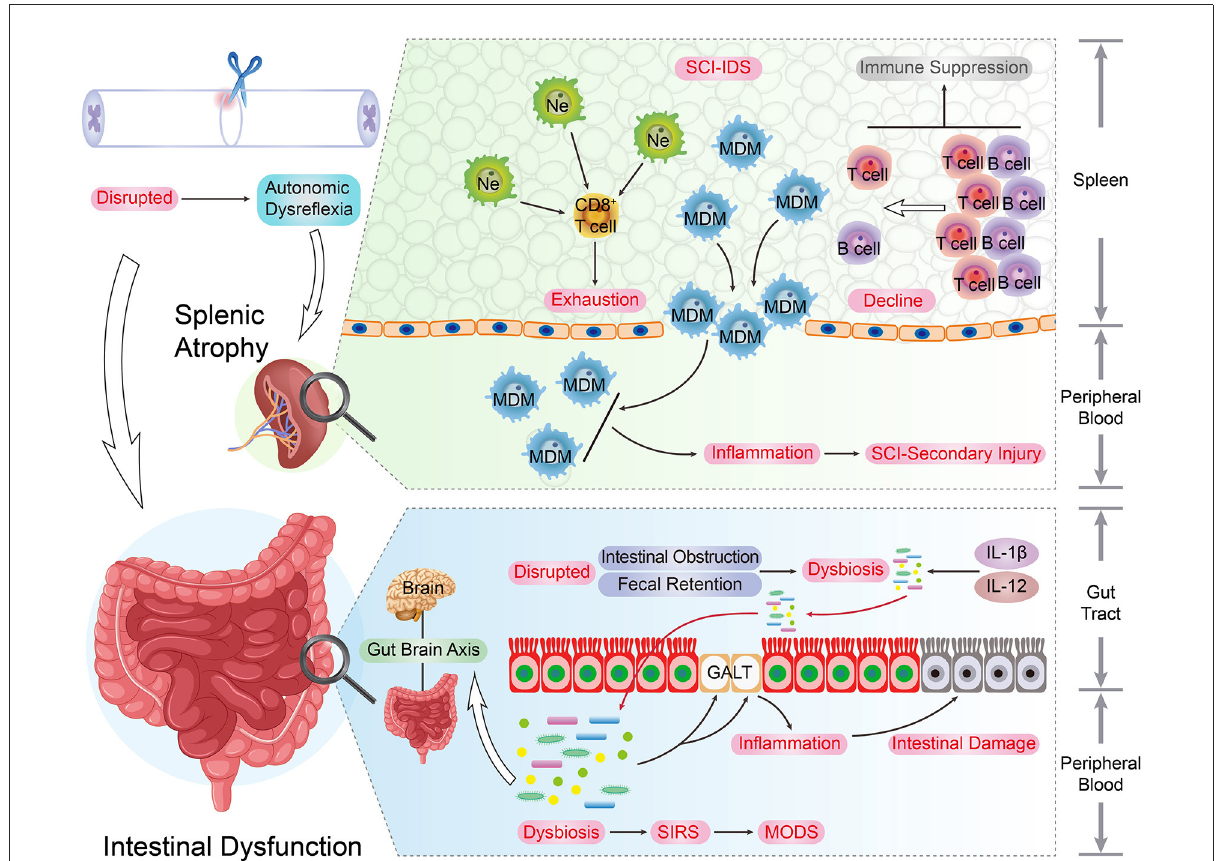
FIGURE3 The immune organs and SCI recovery. As the development and storage places of immune cells, immune organs are indispensable for the immune system’s smooth and effective operation. The upper spinal cord segment injury led to the autonomic dysreflexia status. Under this circumstance, the excessive norepinephrine and activated β -AR signaling result in adverse spleen dysfunction, such as splenic atrophy and immune cells secretion inhibition, and the quantity of peripheral and splenic CD4 + and CD8 + T cells underwent a decrease post-SCI. In addition, due to the surplus norepinephrine stimulation post-SCI, the immune activity and cytokine secretion capacity of splenic CD8 + T cells were impaired. These changes can be regarded as the typical hallmarks of SCI-IDS. Post SCI, the stress-induced intrinsic enteric nervous system interruption results in intestinal complications such as intestinal obstruction, fecal retention, and infections. As consequence, this situation raises the incidence of dysbiosis and induces immunity dysfunction, systemic Inflammatory response syndrome (SIRS), and multiple organ dysfunction syndromes (MODS). Moreover, the SCI-induced pro-inflammatory cytokines up-regulation (IL-1 β and IL-12) takes place in the gut, and the intestinal immune factors disorder condition is parallel with beneficial bacteria reduction